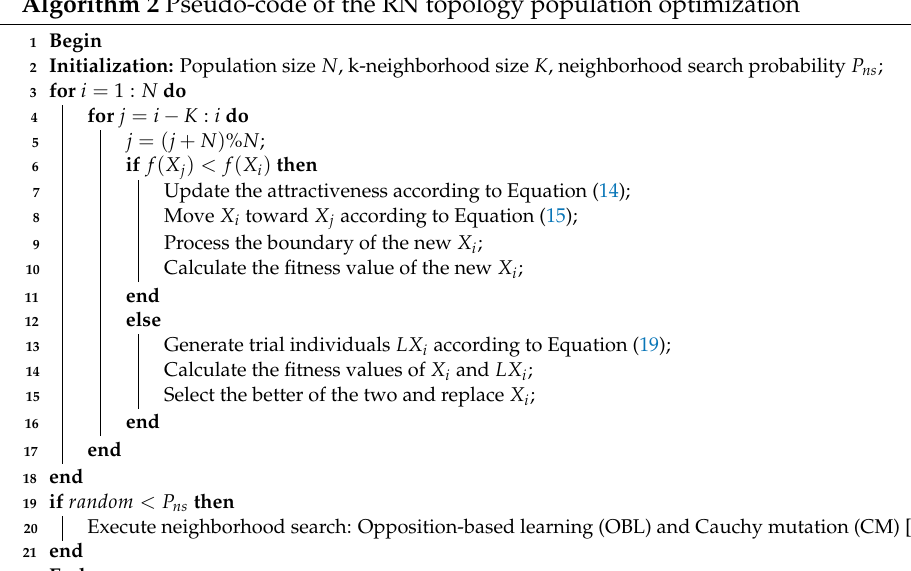
Algorithm 2 Pseudo-code of the RN topology population